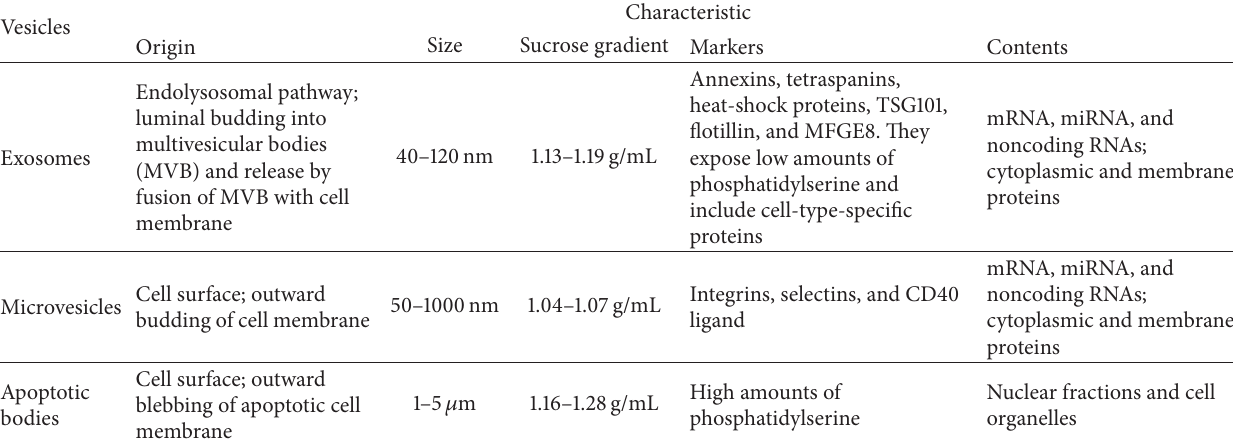
Table 1: Characteristics of the different types of vesicles derived from different biological fluids and conditioned medium.